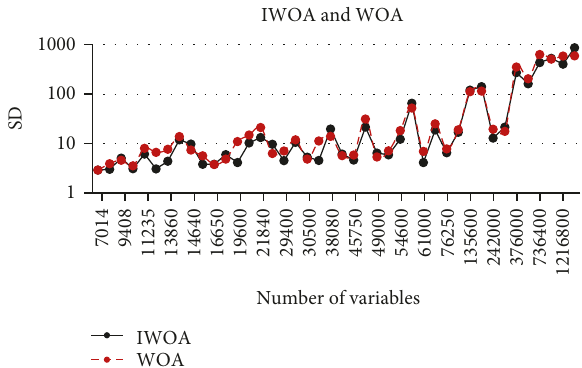
Figure 11: SD comparison of IWOA with WOA for large-scale instances.